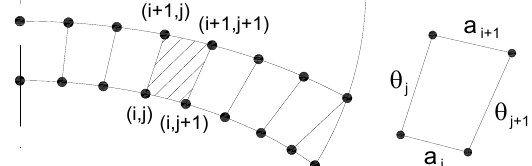
Figure 4: Divisions with the isolines used in the trapezoidal